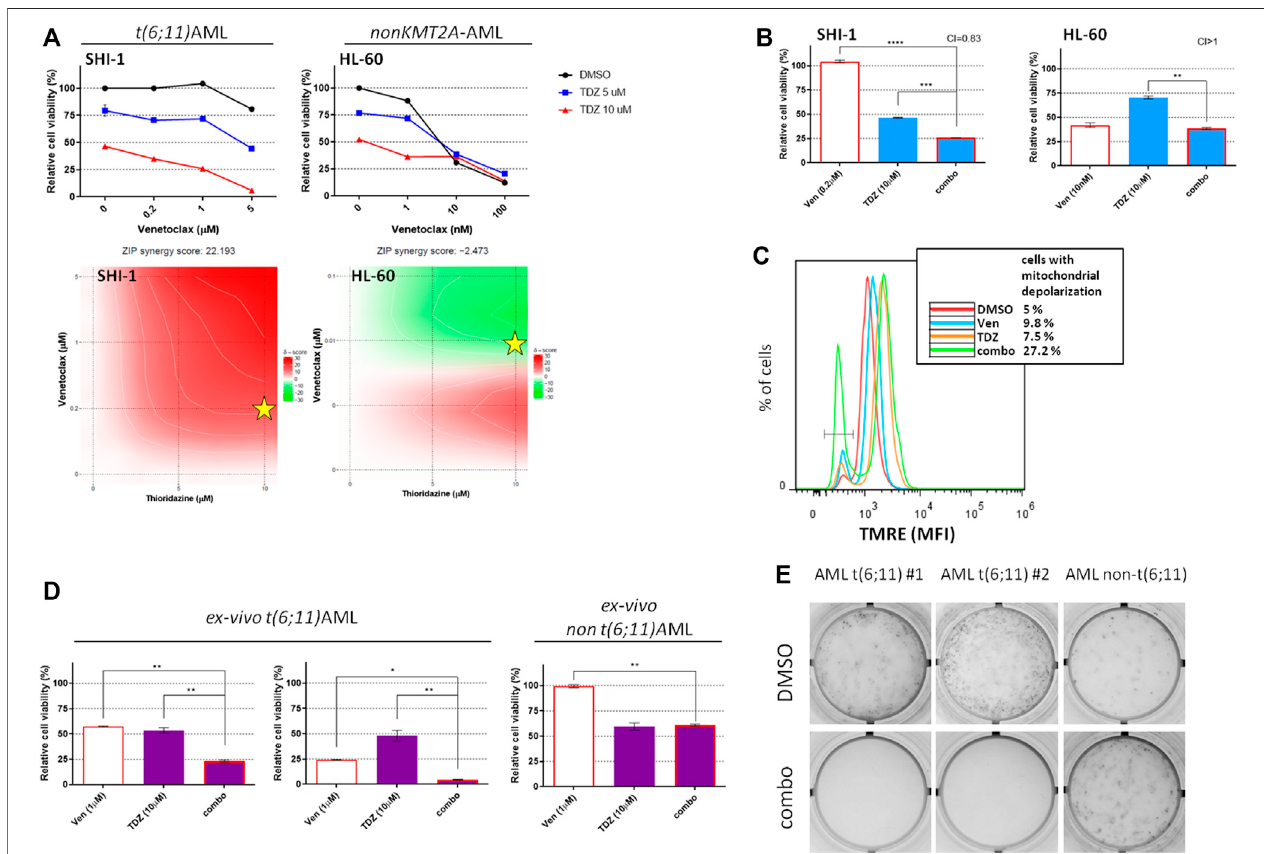
FIGURE 5 | Combination ofvenetoclax and thioridazinein t(6;11)-rearranged acute myeloid leukemia (AML). ( A ) Cell viability of t(6; 11) SHI-1 and non-t (6; 11) HL- 60 after treatment with thioridazine (TDZ) combined with venetoclax (Ven) at 48 h after treatment. The synergy scores were represented by pseudocoloring 2- dimensional contour plots over the dose matrix (red indicates synergy and green indicates antagonism) and calculated using the ZIP model (synergy when > 10, n = 2). Stars indicate the concentrations selected for subsequent experiments. ( B ) Cell viability of t (6; 11) SHI-1 and non-t (6; 11) HL-60 after treatment with venetoclax, thioridazine, or the combination at 48 h after treatment (CI, combination index; synergy when CI < 1. ANOVA test was performed by applying Bonferroni correction for multiple statistical hypotheses testing. ** p < 0.01, *** p < 0.001; **** p < 0.0001; n = 2). ( C ) Mitochondrial depolarization evaluated by tetramethylrhodamine ethyl fl uorescence measurement at 20 h after Ven (5 µM), TDZ (10 µM), or combination treatment compared with dimethyl sulfoxide in SHI-1 ( n = 2). ( D ) Cell viability of PDX- derived ex vivo t (6; 11) and non-t (6; 11) AML after treatment with venetoclax (1 µM), thioridazine (10 µM) or the combination at 24 h after treatment. ANOVA test was performed by applying Bonferroni correction for multiple statistical hypotheses testing.* p < 0.05; ** p < 0.01. ( E ) Colony-forming assay performed on viable ex vivo cells seeded at 24 h after the combination treatment [venetoclax (1 µM) + thioridazine (10 μ M), n =